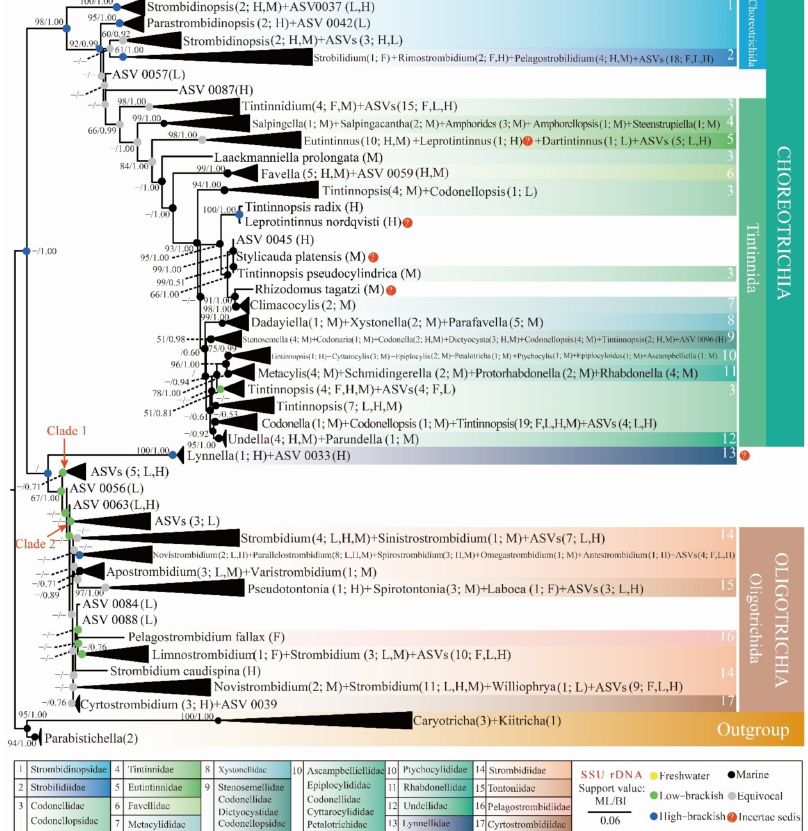
Figure 4. Maximum likelihood (ML) tree based on SSU rDNA of 103 environmental sequences (ASVs in DADA2–100) and 197 sequences of identified species from GenBank (accession numbers in Supplementary Table S1). The tree shows the topology and transition pattern; support values (ML/BI) > 50%/0.50 are labeled. The number of collapsed sequences and ecological characteristics are shown in parentheses. F, freshwater; L, low-brackish; H, high-brackish; M,